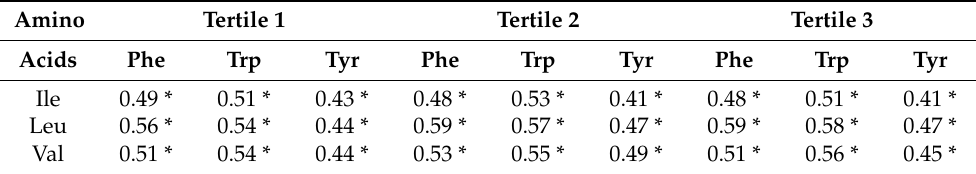
Table 3. Correlation coefficients between the concentrations of BCAAs and AAAs for healthy control subjects and subjects with hypertension derived by Spearman rank correlation analysis. Amino Tertile 1 Tertile 2 Tertile 3 Acids Phe Trp Tyr